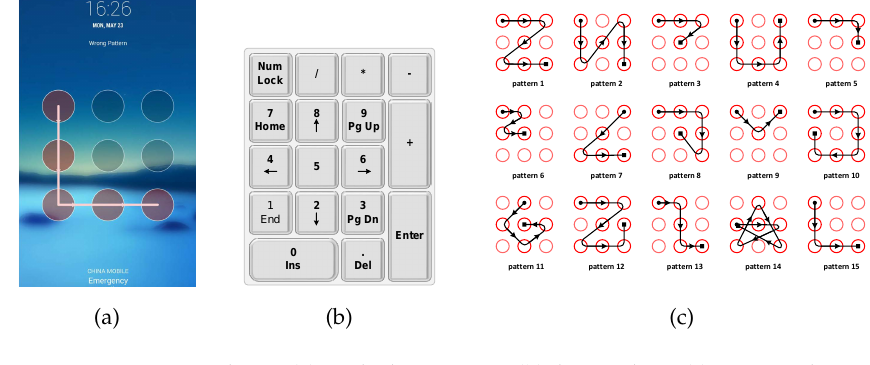
Figure 11. Two case studies. ( a ) Unlock patterns; ( b ) keystrokes; ( c ) 15 tested patterns for Android applications.